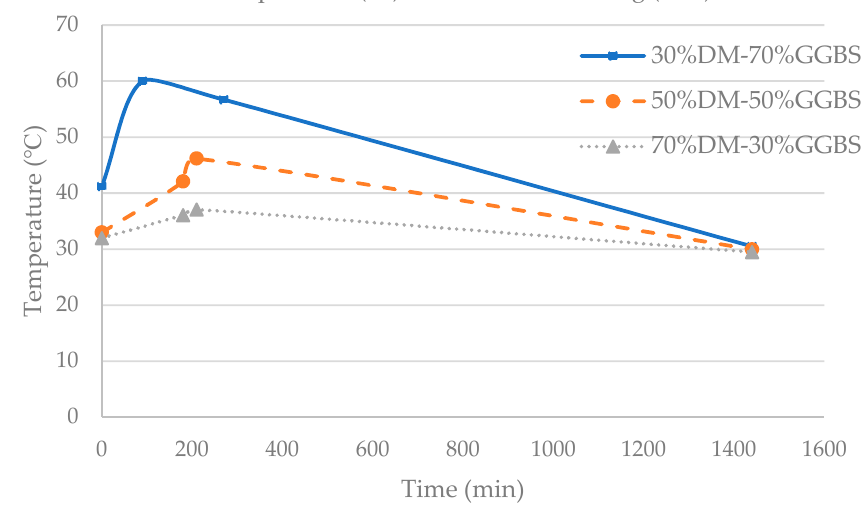
Figure 1. Internal temperature (°C) vs. Time from casting (min).